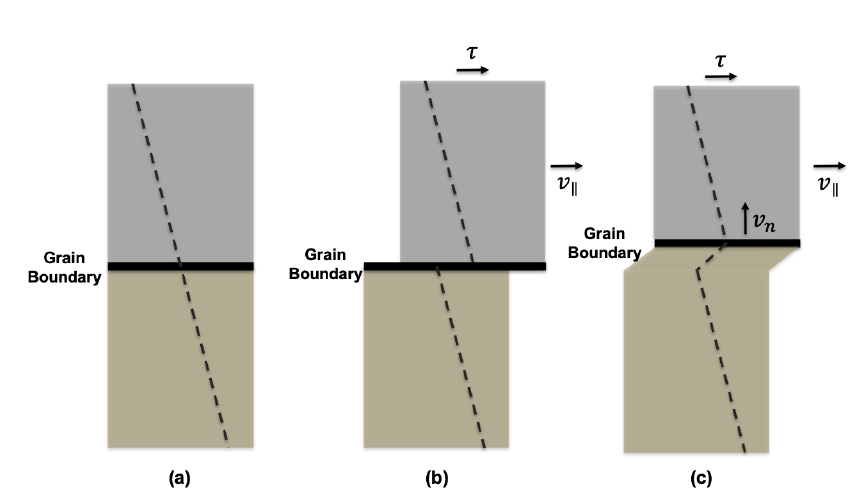
Figure 4. Illustration of the concept of shear-coupled motion. The left panel ( a ) shows the reference state with a horizontal grain boundary. The dashed line is a marker across the grain boundary to track the motion of lattice planes. Panel ( b ) shows the case of pure sliding motion. The upper grain is subjected to a lateral motion with velocity v (cid:107) by application of an external shear stress τ . As a result, the upper grain “slides” along the lower one, similar to a frictional process [21,22]. As a consequence, the dashed marker line becomes discontinuous at the grain boundary. The right panel ( c ) shows the consequences of shear-coupled motion. While the grains have a relative lateral velocity v (cid:107) , simultaneously, a normal motion of the grain boundary takes place with velocity v n . This happens because atoms from the upper grain connect to the lower grain during the motion at the moment when a layer of upper grain atoms aligns with the lattice of the lower grain. Notice that an inversion of the tangential velocity also changes the orientation of the normal interface motion. As a result of the normal grain boundary motion, the marker line develops a kink